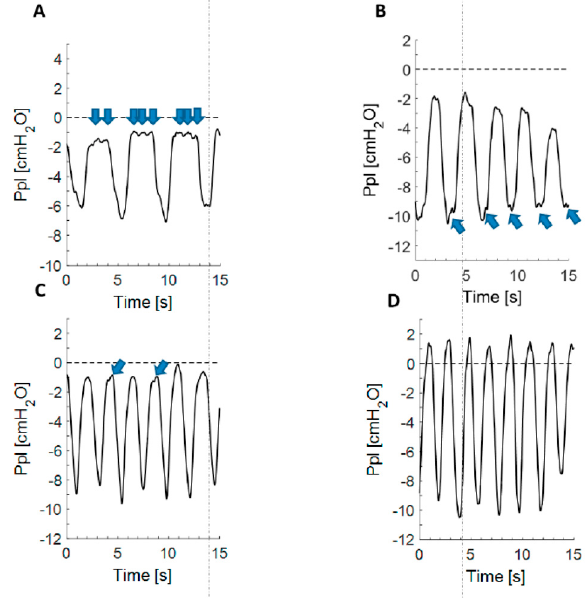
Figure 2. Exemplary pleural pressure curves representing study subgroups. ( A ) Pleural pressure curve with well visible waves (waves +) during end-expiratory phase; ( B ) Pleural pressure curve with well visible waves (waves +) during end-inspiratory phase ; ( C ) An extract of pleural pressure curve with poorly visible waves (waves +/ − ); ( D ) An extract of pleural pressure curve with undetectable waves (waves − ). Pleural pressure pulse is marked with arrows.